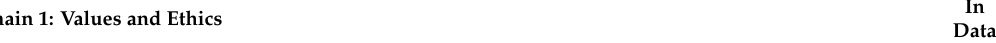
Table 1. Study Domains and Themes and Their Occurrence in the